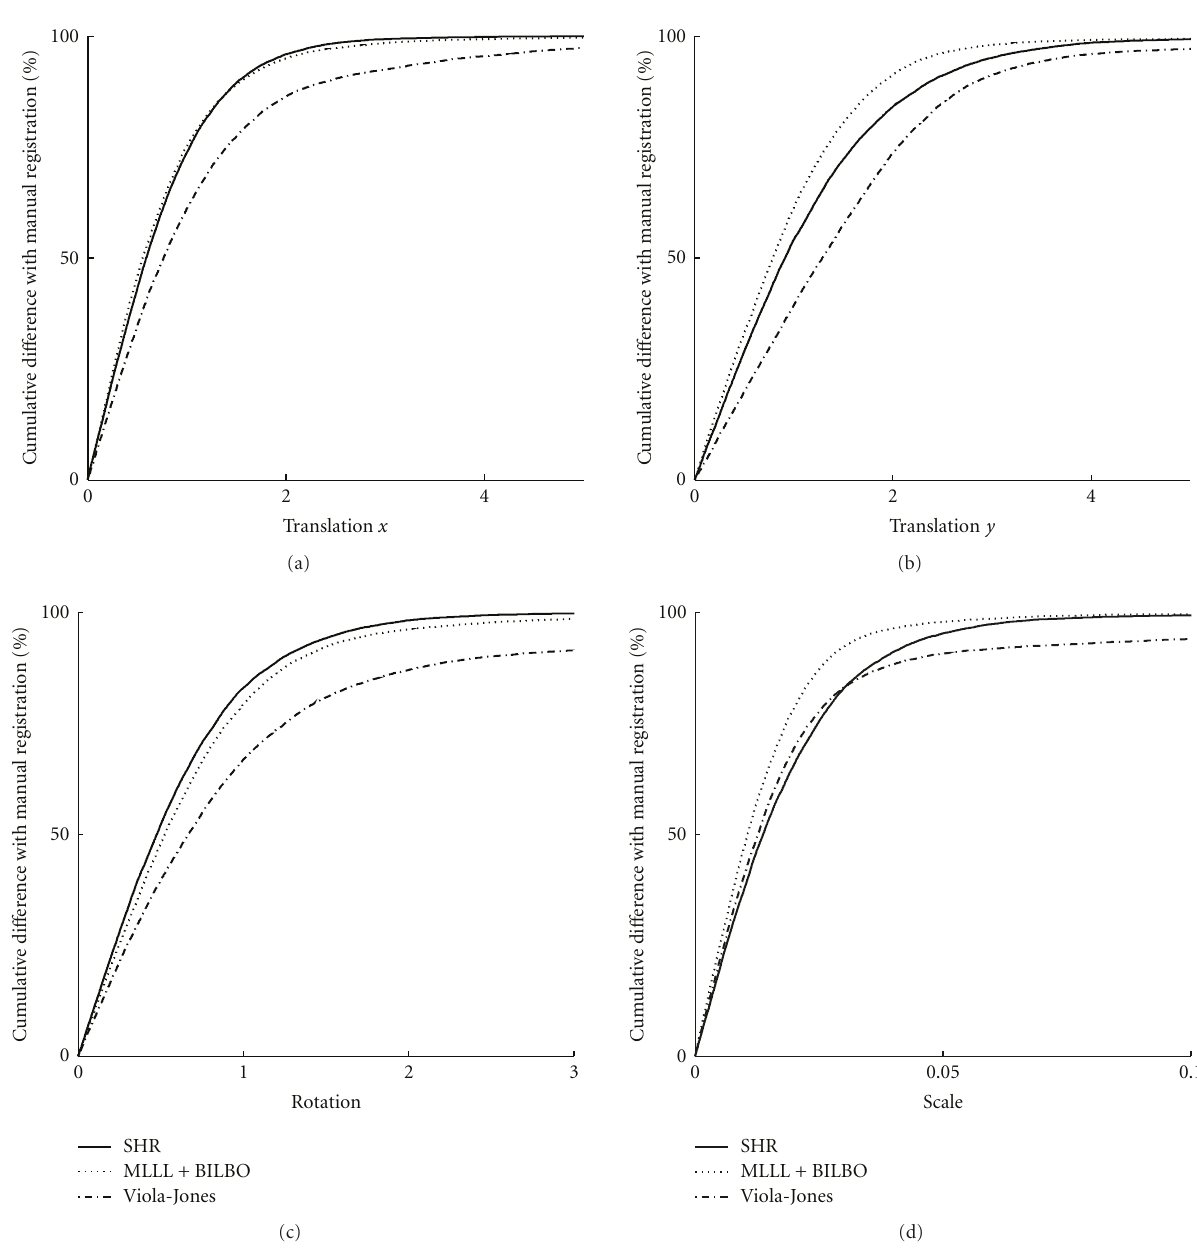
Figure 8: Cumulative di ff erences of registration parameters compared with manual registration, showing that MLLL + BILBO produces very accurate landmarks and that SHR and Manual di ff er especially in scale and translation in y